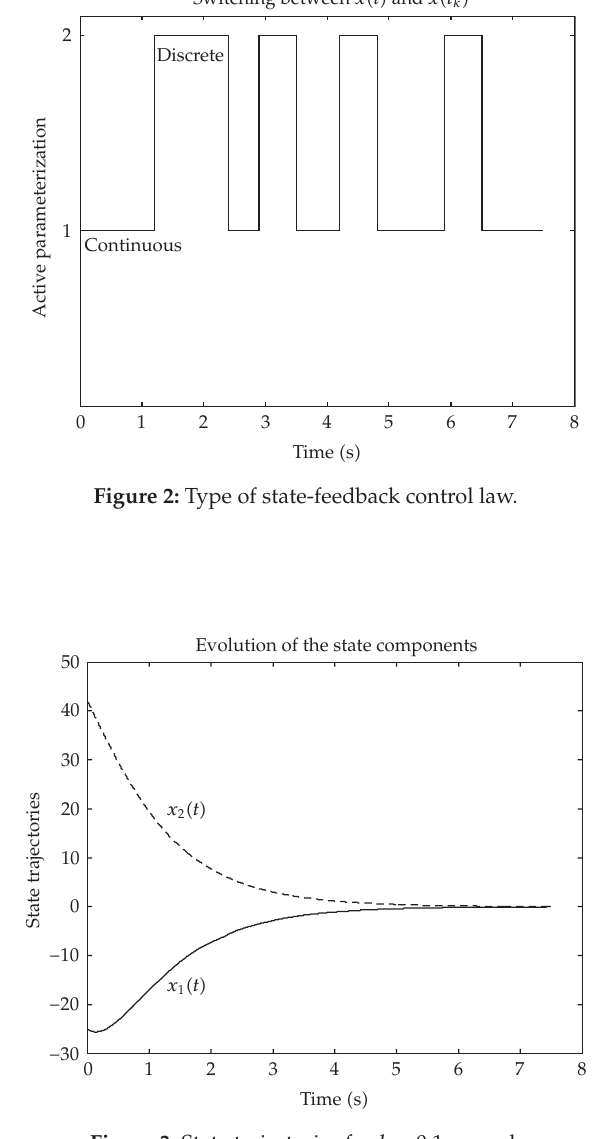
Figure 3: State trajectories for h (cid:8) 0 . 1